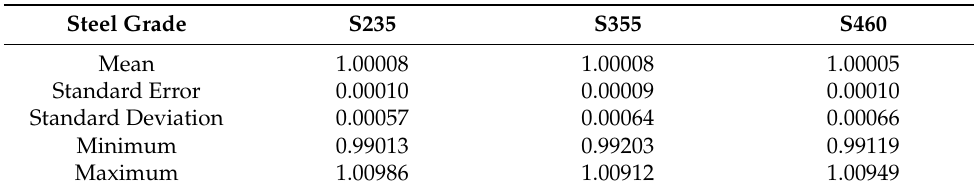
Table 2. Descriptive statistics for individual buckling factor vs. average buckling factor for the whole